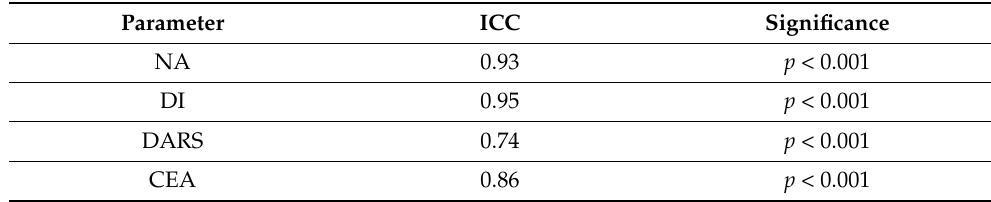
Table 3. Intra-class correlation coefficient (ICC) for inter-observer variability between the